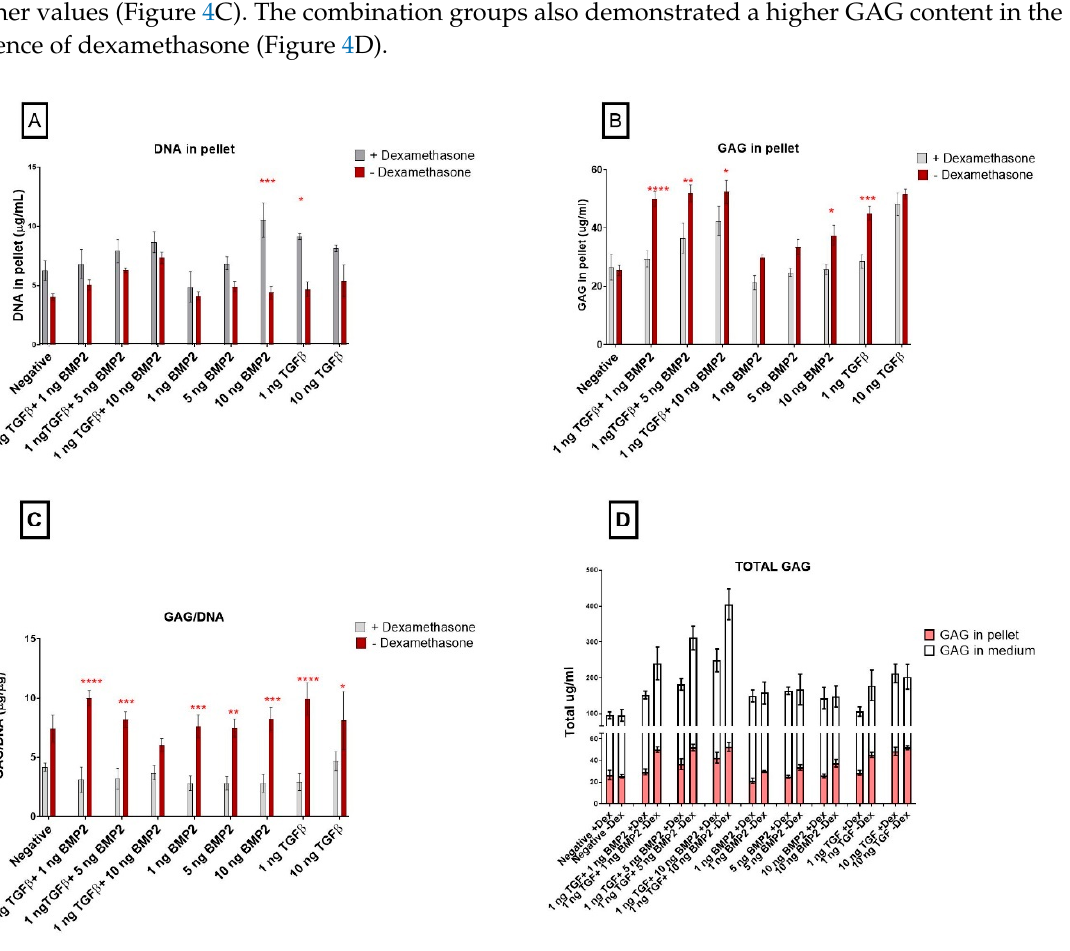
Figure 4. The effect of dexamethasone on glycosaminoglycan and DNA content in the pellets. Cells were cultured for 21 days in the presence of 10 ng/mL TGF- β 1 (positive control) or in its absence (negative), low TGF- β 1 concentration (1 ng/mL TGF- β 1), various concentration of BMP-2 alone (1 5 ng / mL BMP-2, 10 ng / mL BMP-2) or BMP-2 in combination with TGF- β 1 (1 ng / mL TGF- β 1 + 1 ng / mL ng/mL BMP-2, 5 ng/mL BMP-2, 10 ng/mL BMP-2) or BMP-2 in combination with TGF- β 1 (1 ng/mL BMP-2, 1 ng / mL TGF- β 1 + 5 ng / mL BMP-2 and 1 ng / mL TGF- β 1 + 10 ng / mL BMP-2) ( A ). The amount TGF- β 1 + 1 ng/mL BMP-2, 1 ng/mL TGF- β 1 + 5 ng/mL BMP-2 and 1 ng/mL TGF- β 1 + 10 ng/mL BMP- 2) ( A ). The amount of glycosaminoglycans in the pellets were normalized to the DNA content ( B ) (pink bars) ( C ). Grey bars represent di ff erent measurement in hSDSC exposed to dexamethasone, (mean ± SD; n = 4). Total GAG is shown as GAG released in the medium (white bars) plus GAG red bars di ff erent measurement in hSDSC in dexamethasone-free media. DNA content for pellets are retained inside the pellets (pink bars) ( C ). Grey bars represent different measurement in hSDSC shown in panel ( D ). Data are expressed as mean ± SD, significant di ff erence from dexamethasone exposed to dexamethasone, red bars different measurement in hSDSC in dexamethasone-free media. treatment in the same group is marked by red asterisks; significant di ff erence among groups is marked DNA content for pellets are shown in panel ( D ). Data are expressed as mean ± SD, significant by black asterisks (* p ≤ 0.05, ** p ≤ 0.01, *** p ≤ 0.001, **** p ≤ difference from dexamethasone treatment in the same group is marked by red asterisks; significant difference among groups is marked by black asterisks (* p ≤ 0.05, ** p ≤ 0.01, *** p ≤ 0.001, **** p ≤ 0.0001).